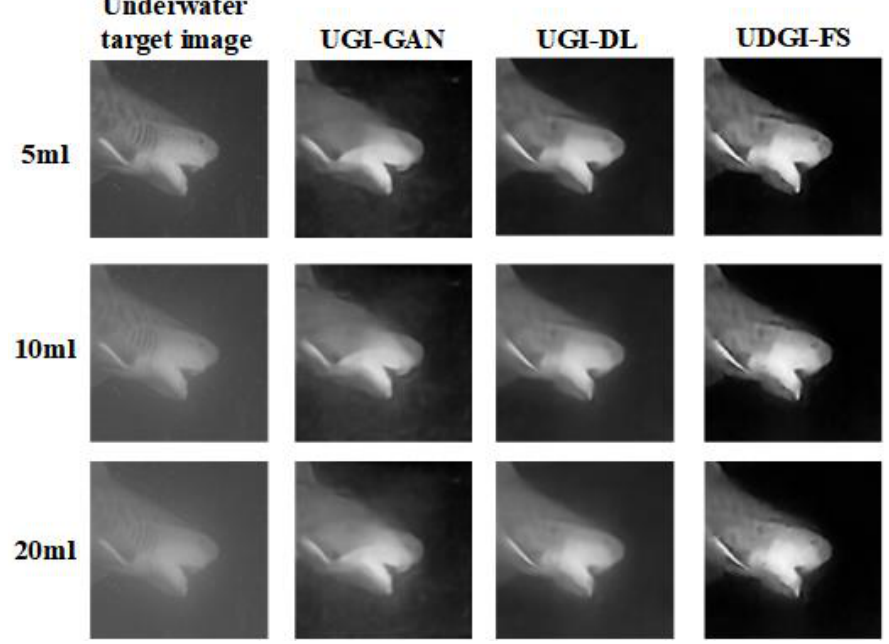
Figure 16. Comparison of reconstructed shark images of UDGI-FS, UGI-DL, and UGI-GAN at different degrees of underwater blurring.